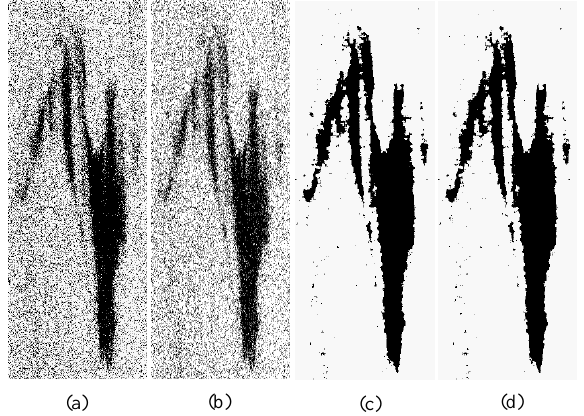
Figure 4. Results of SVM classification in first step. The classified image obtained from (a) power of VV polarization. (b) Pauli decomposition. (c) Krogager decomposition. (d) Freeman decomposition